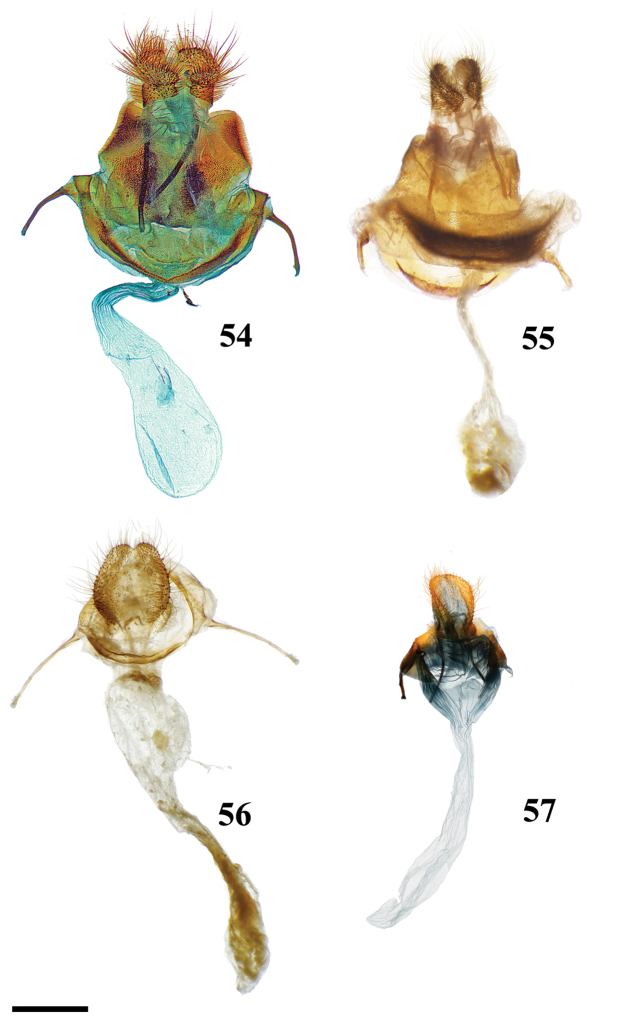
Ventral view of female genitalia of type species (except where noted) of genera belonging to Lacosominae: Trogopterini and Lacosomini. 54Reinmaraenthona, D. Herbin genitalia diss.: H. 1103 [reused with permission from St Laurent et al. (2017d), Tropical Lepidoptera Research] (CDH) 55Trogopteratirzaha, St Laurent diss.: 3-31-18:4, not the type species of Trogoptera (MGCL) 56Lacosomachiridota, St Laurent diss.: 3-31-18:3 (MGCL) 57Vanengamera, St Laurent diss.: 5-17-16:5 [reused with permission from St Laurent and Herbin (2017), ZooKeys] (CUIC). Scale bar: 1 mm.